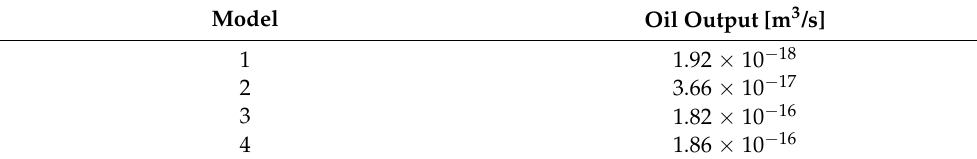
Table 5. Oil output statistics.